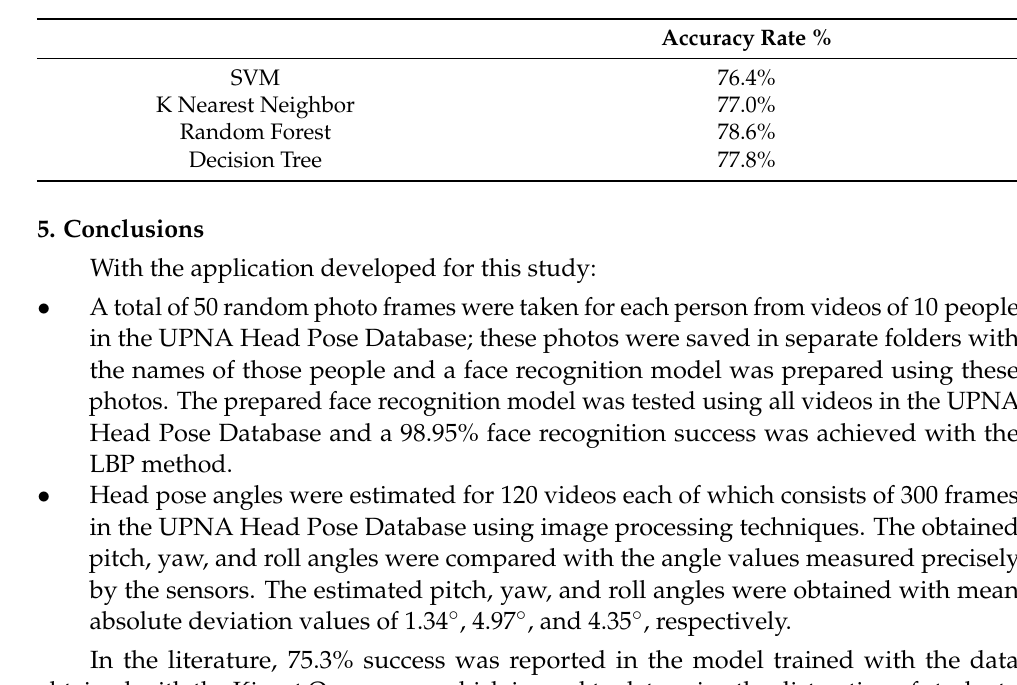
Table 6. Overall success of SECS—second scenario (by using Euler angles measured with